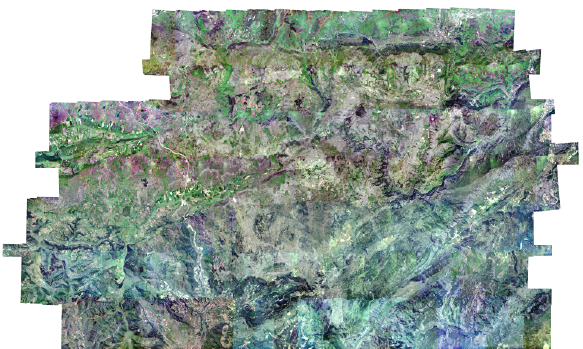
Figure 12. Orthophotomosaic with improved Wallis filtering correction using optimal window